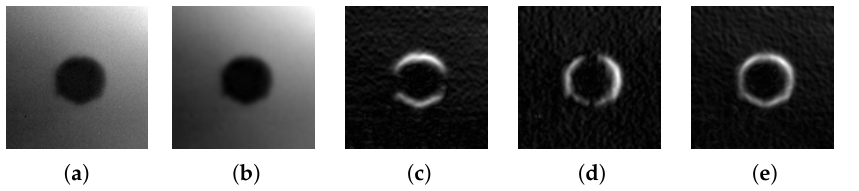
Figure 1. One frame from a thermal video showing a rivet in a surrounding plate. In ( a ), the unfiltered data are shown, in ( b ) the data after applying a two-dimensional median filter (three pixel window size) and ( c , d ) show the gradient in x and y direction respectively. Image ( e ) shows the final result and the edge of the loose